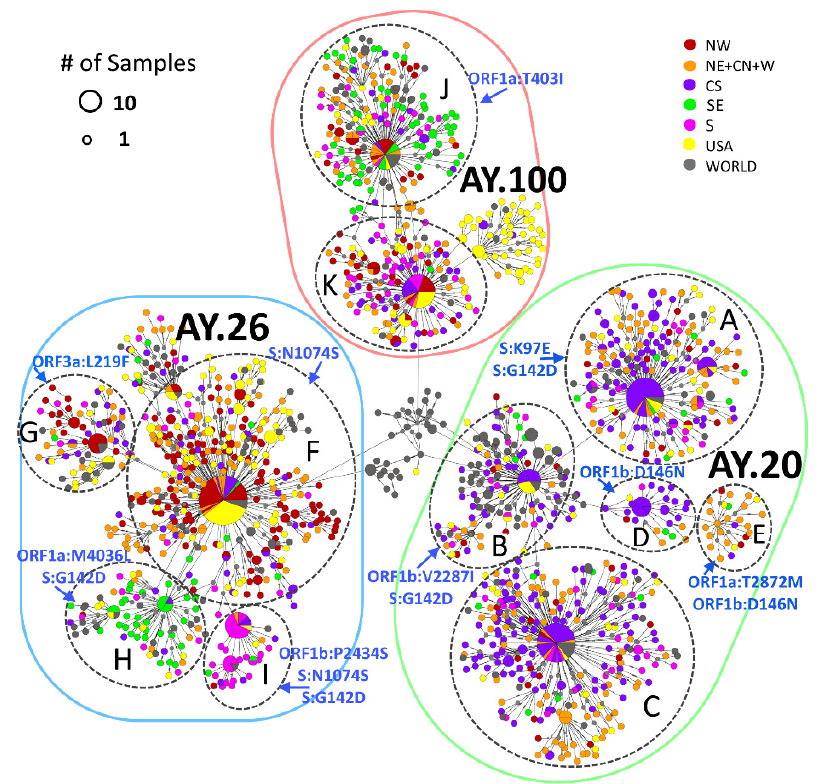
Figure 4. Haplotype network using mutations from AY.20, AY.26, and AY.100 sublineages in Mexico and worldwide. Colors indicate the Mexican regions sequences were isolated, with yellow and gray circles representing the USA and the rest of the world, respectively. The size of the circles indicates the number of samples within the same haplotype (scale is provided). Main subclusters within each lineage are marked with black discontinuous circles, and their specific mutations are indicated in blue.